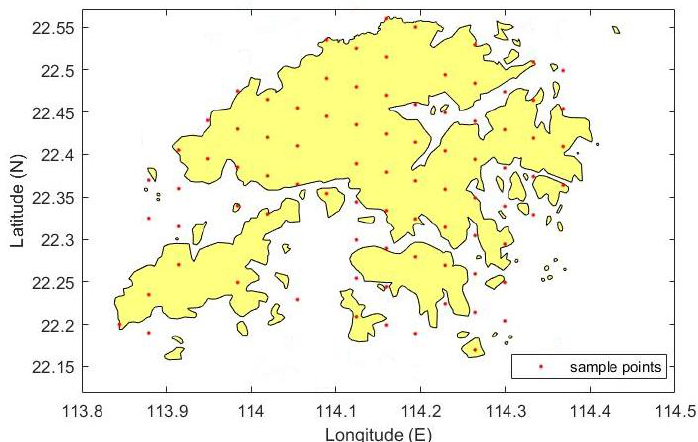
Figure 5. Distribution of 98 sample points selected through filtering approach.